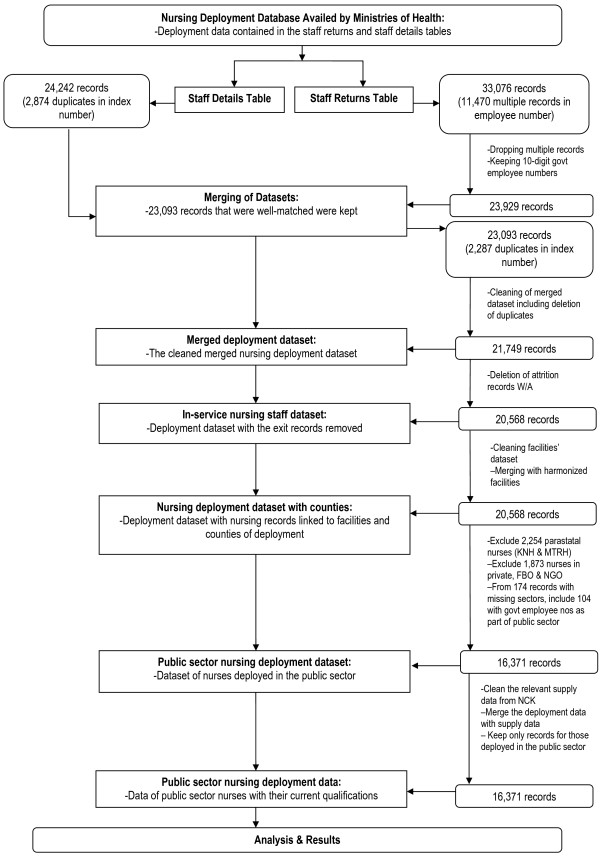
Methods used to obtain the public sector nursing staff data. Illustrated are the methods used to clean the data from the Ministries of Health, to extract the data on the 16,371 nurses deployed in the public sector (excluding those in national referral hospitals) and merging the same to data from the Nursing Council of Kenya so as to obtain the qualifications of the public sector nurses.